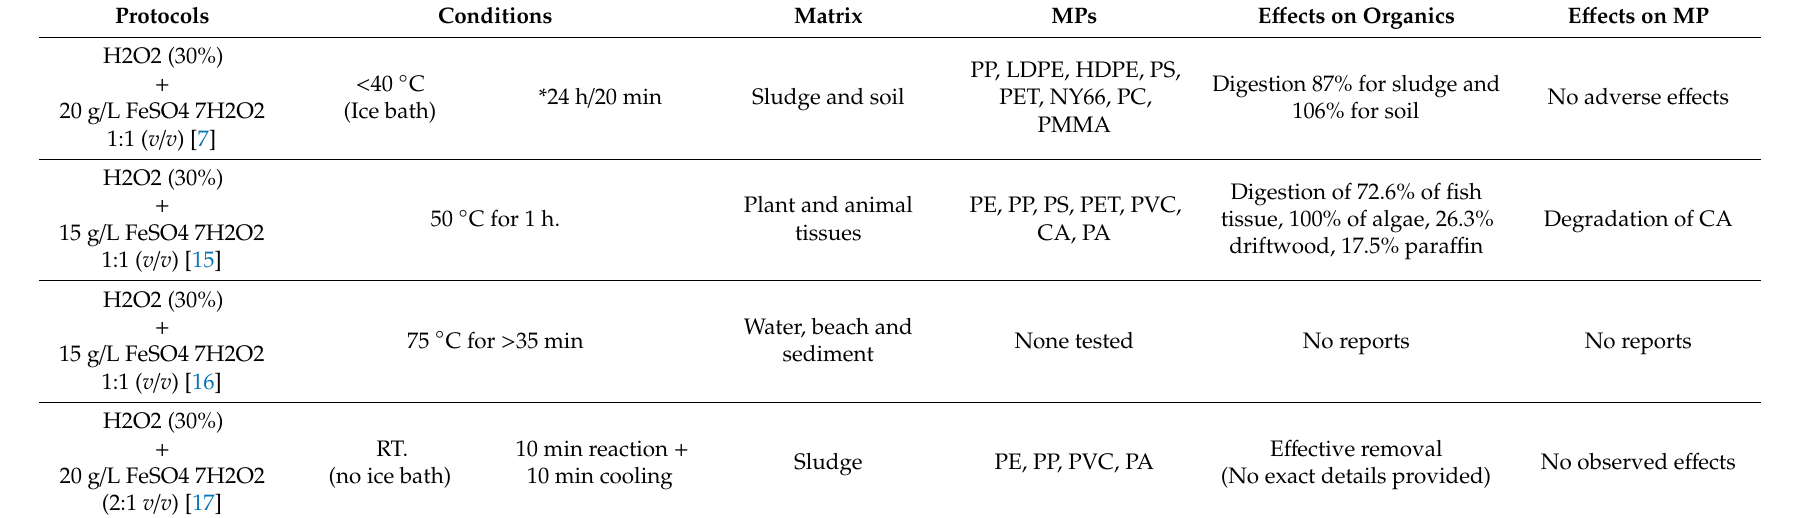
Table A2. Summary of various Fenton protocols used in microplastic studies. RT—Room Temperature.